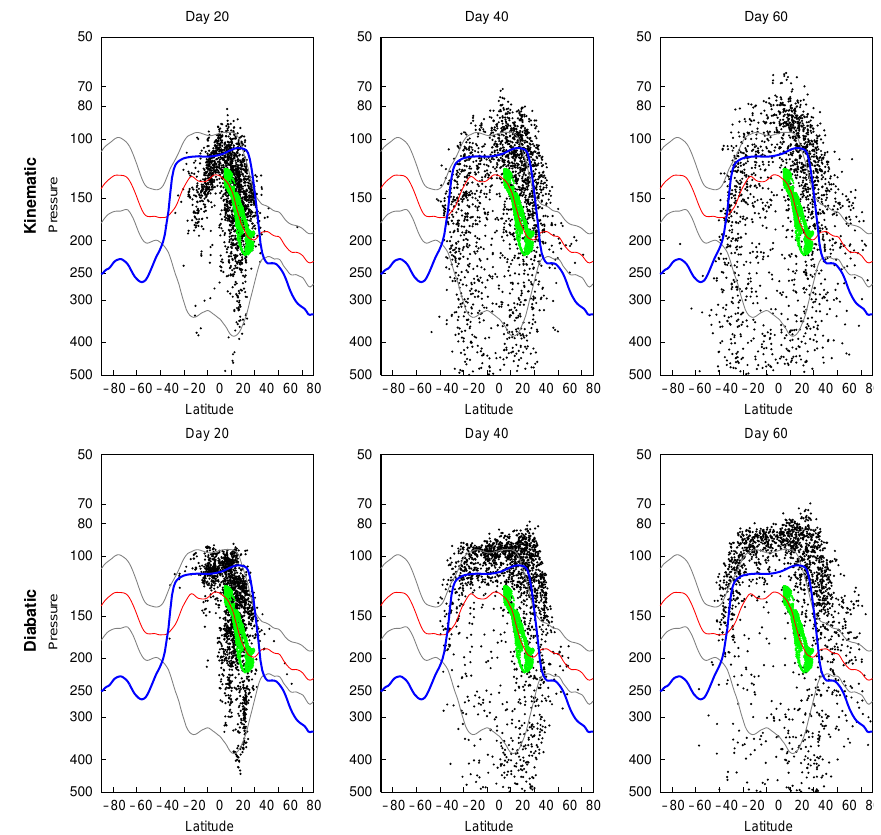
Figure 5. Trajectories released within the anticyclone at 360K on 10 June after 20, 40 and 60 days for kinematic (top panels) and diabatic (bottom panels) calculation of vertical transport. Green dots mark the initial location. The blue line is the mean thermal tropopause at 20–120 ◦ E, the red line the mean 360K isentrope and the gray lines the 340 and 380K